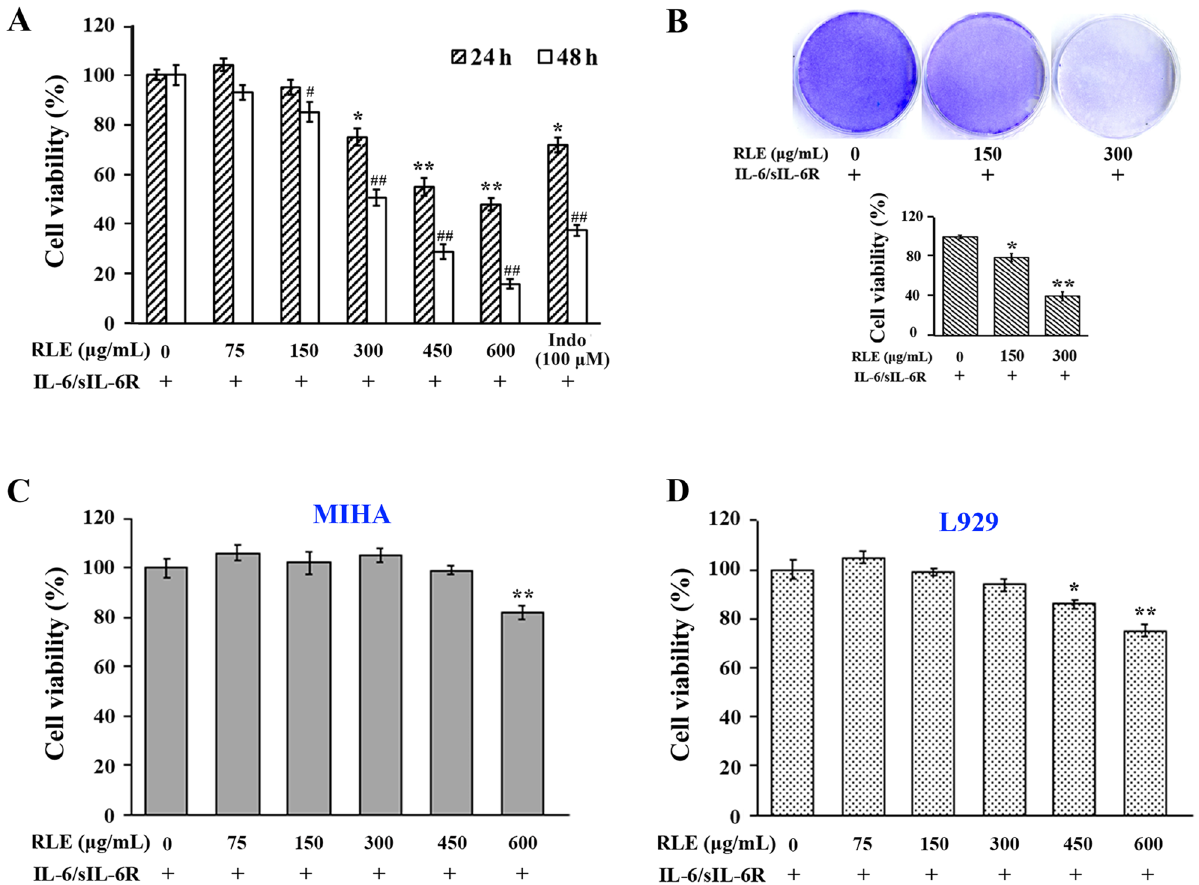
Figure 2. RLE reduced viability of RA-FLS. ( A ) CCK-8 assays in IL-6/sIL-6R-stimulated synoviocytes. Cell viability results are from 3 independent experiments. Viability of RLE-untreated cells was regarded as 100%. * P < 0.05, ** P < 0.01 vs. RLE-untreated (24 h) group. # P < 0.05, ## P < 0.01 vs. RLE-untreated (48 h) group. ( B ) Crystal violet staining of IL-6/sIL-6R-stimulated synoviocytes. Representative images are shown in the upper panel, and quantitative results are shown in the lower panel (n = 3). ( C ) CCK8 assays in IL-6/sIL-6R-stimulated L929 cells. ( D ) CCK8 assays in IL-6/sIL-6R-stimulated MIHA cells. In ( C , D ), cell viability results are from 3 independent experiments. In ( B – D ), * P < 0.05, ** P < 0.01 vs. RLE-untreated group whose cell viability was regarded as crystal violet staining assays were performed. RLE dose- and time-dependently reduced viability of IL-6/sIL- 6R-stimulated synoviocytes in CCK-8 assays (Fig. 2A). The anti-proliferative effects of 450 μg/mL of RLE were comparable to that of 100 μM of indomethacin (Fig. 2A). Crystal violet staining visualized RLE’s inhibitory effects on RA-FLS proliferation (Fig. 2B). To determine the effects of RLE on the proliferation of normal cells, mouse fibroblast L929 and human normal liver-derived MIHA cells were used. In the presence of IL-6/sIL-6R, the anti-proliferative effects of RLE in both L929 and MIHA lines were weak (Fig. 2C,D) and less potent than in RA-FLS (Fig. 2A,B). To determine the effects of RLE on apoptosis of synoviocytes, Annexin V-FITC/PI double staining assays were conducted. RLE dose-dependently induced apoptosis in IL-6/sIL-6R-stimulated synovio- cytes (Fig. 3A). RLE’s apoptotic effects were verified by its ability to dose-dependently cleave caspase-3 and cas- pase-9 (Fig. 3B). As compared with the solvent treatment, IL-6/sIL-6R stimulation did not significantly affect synoviocyte apoptotsis (data not shown). These findings indicate that RLE inhibits proliferation of, and induces apoptosis in, IL-6/sIL-6R-stimulated RA-FLS. RLE lowers the protein level of p‑STAT3 in synovia of CIA rats. In the mechanistic studies, we found that protein level of phospho-STAT3 (Tyr 705) in synovial tissues was higher in CIA rats than in normal rats, and RLE treatments significantly and dose-dependently down-regulated the level of this protein (Fig. 4). Indomethacin also inhibited phosphorylation of STAT3 in synovia of CIA rats (Fig. 4), which is in line with a previous report 22 . These data indicate that RLE inhibits STAT3 activation in synovia of CIA rats. RLE inhibits STAT3 signaling in IL‑6/sIL‑6R‑stimulated RA‑FLS. In cell assays, IL-6/sIL-6R stimu- lation time-dependently promoted the activation/phosphorylation at site Tyr705 of STAT3 in RA-FLS, with a peak at 40 min (Fig. 5A). Synoviocytes stimulated with IL-6/sIL-6R for 40 min were used as the cell model